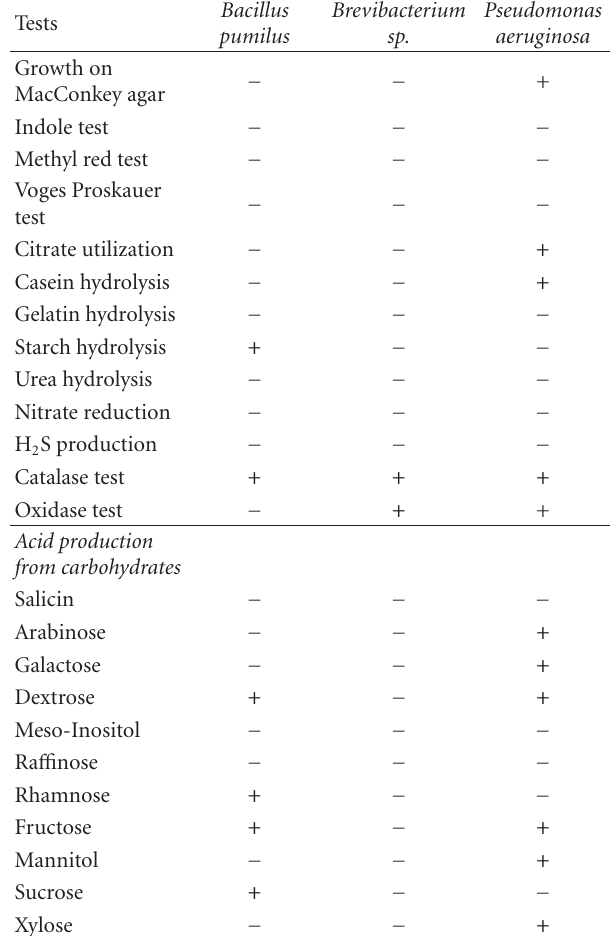
Table 4: Biochemical test of identified